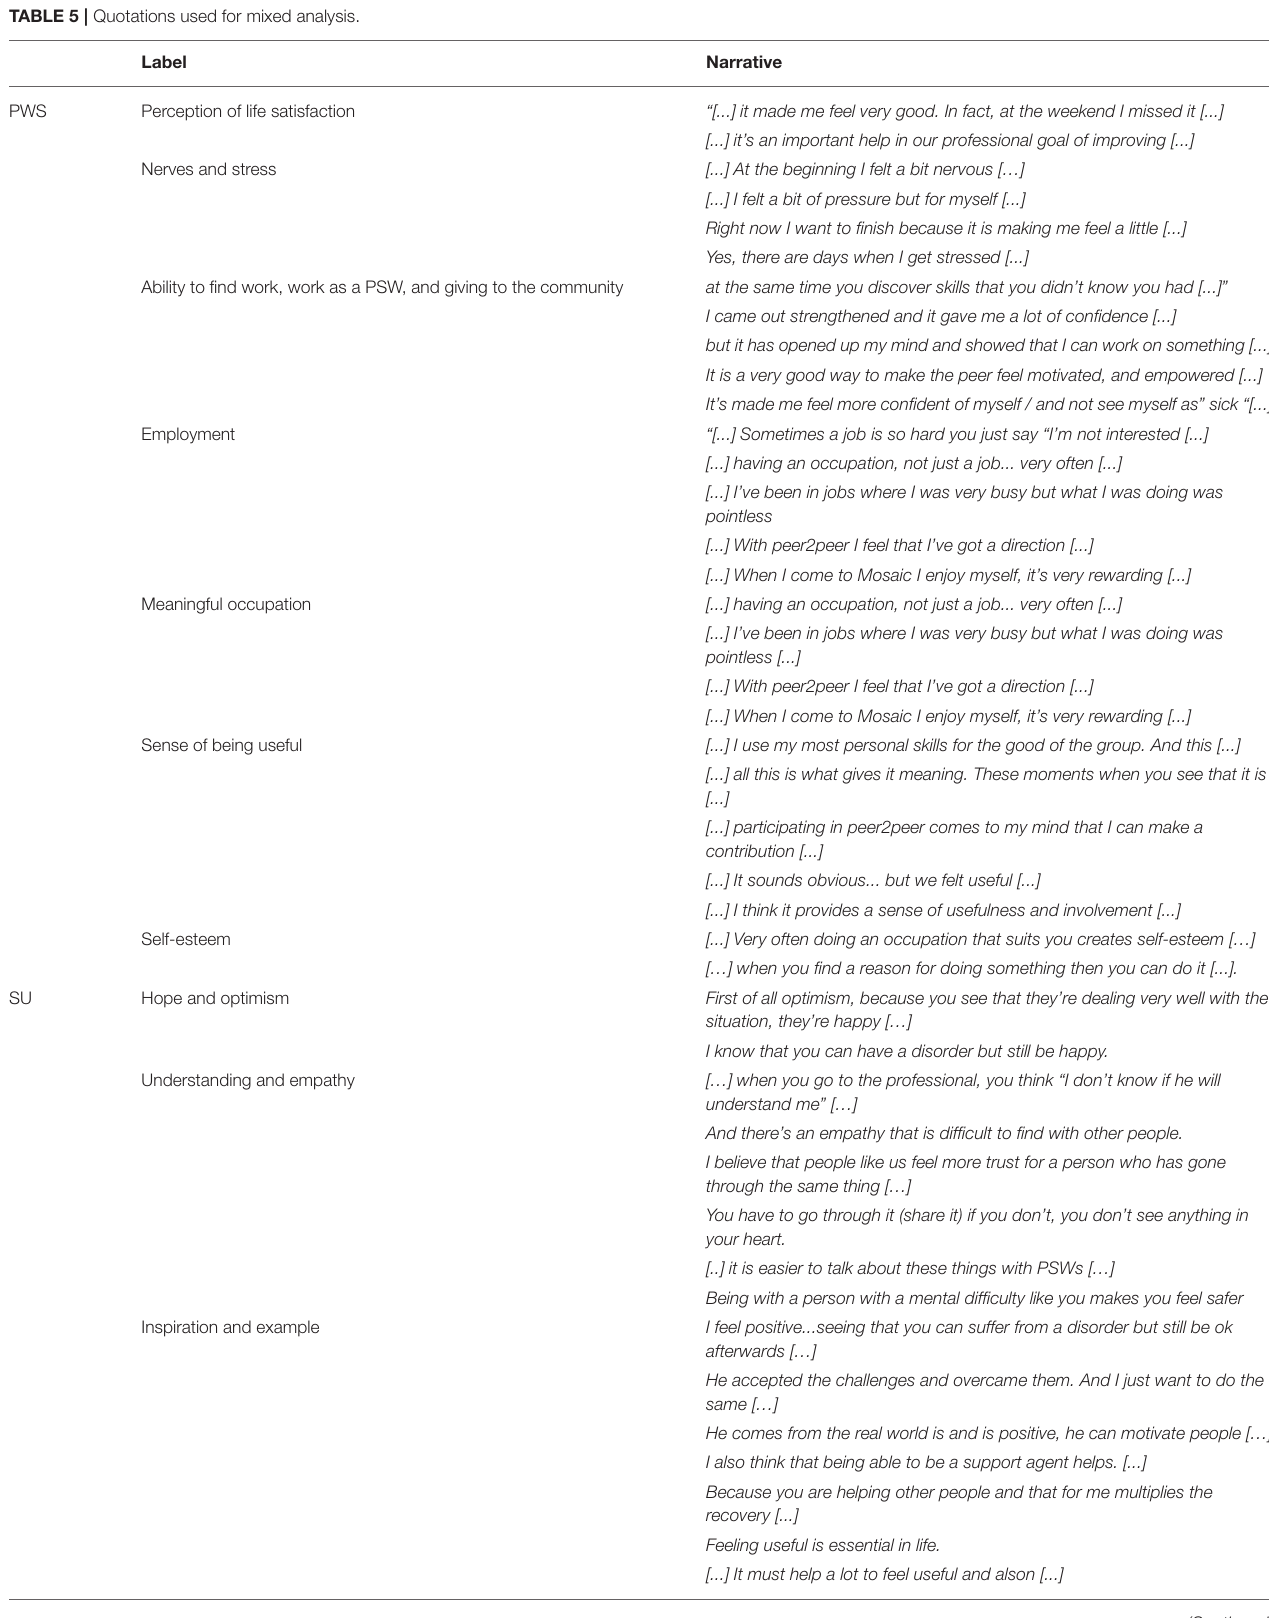
TABLE 5 | Quotations used for mixed analysis.